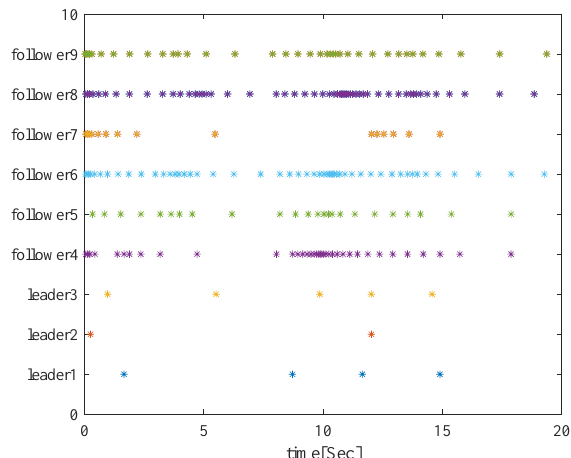
Figure 5. Event-trigger numbers under the event-based control law of Equation